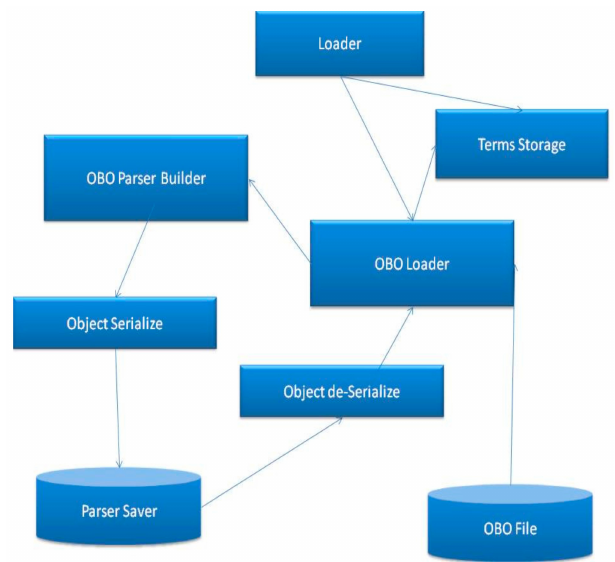
Figure 4. Open Biomedical Ontologies (OBO) file